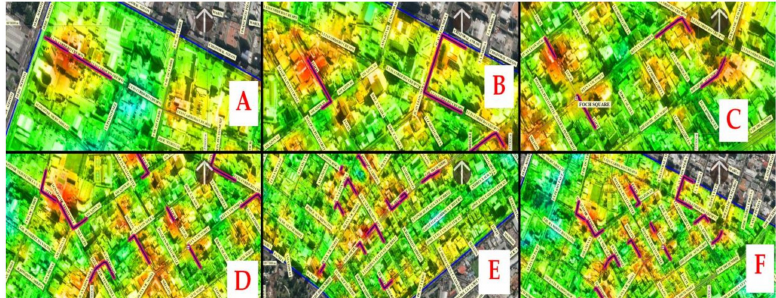
Figure 14. Escape routes near the areas of greatest exposure that the population can reach in a very short time between 1 and 4 min (red-black double line routes in the figures from A – F